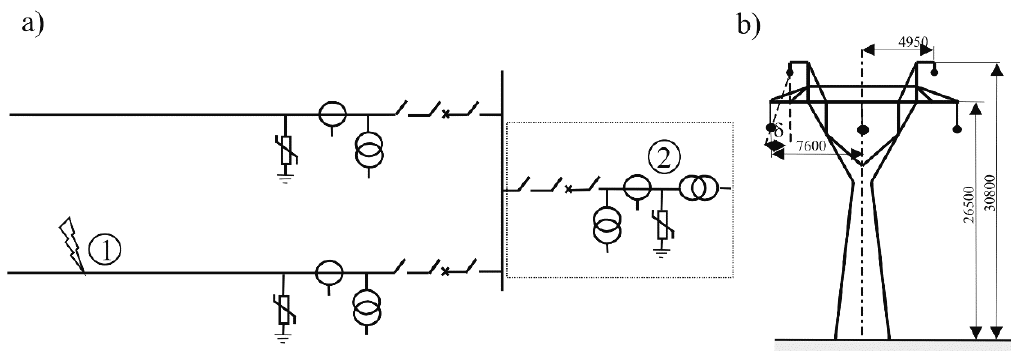
Figure 2. ( a ) Substitute scheme of the part of the overhead transmission lines and power substation of 220 kV, ( b ) basic dimensions of the tower of 220 kV overhead transmission lines [28]: 1—Point of lightning strokes; 2, 3—the points for simulations of overvoltages .